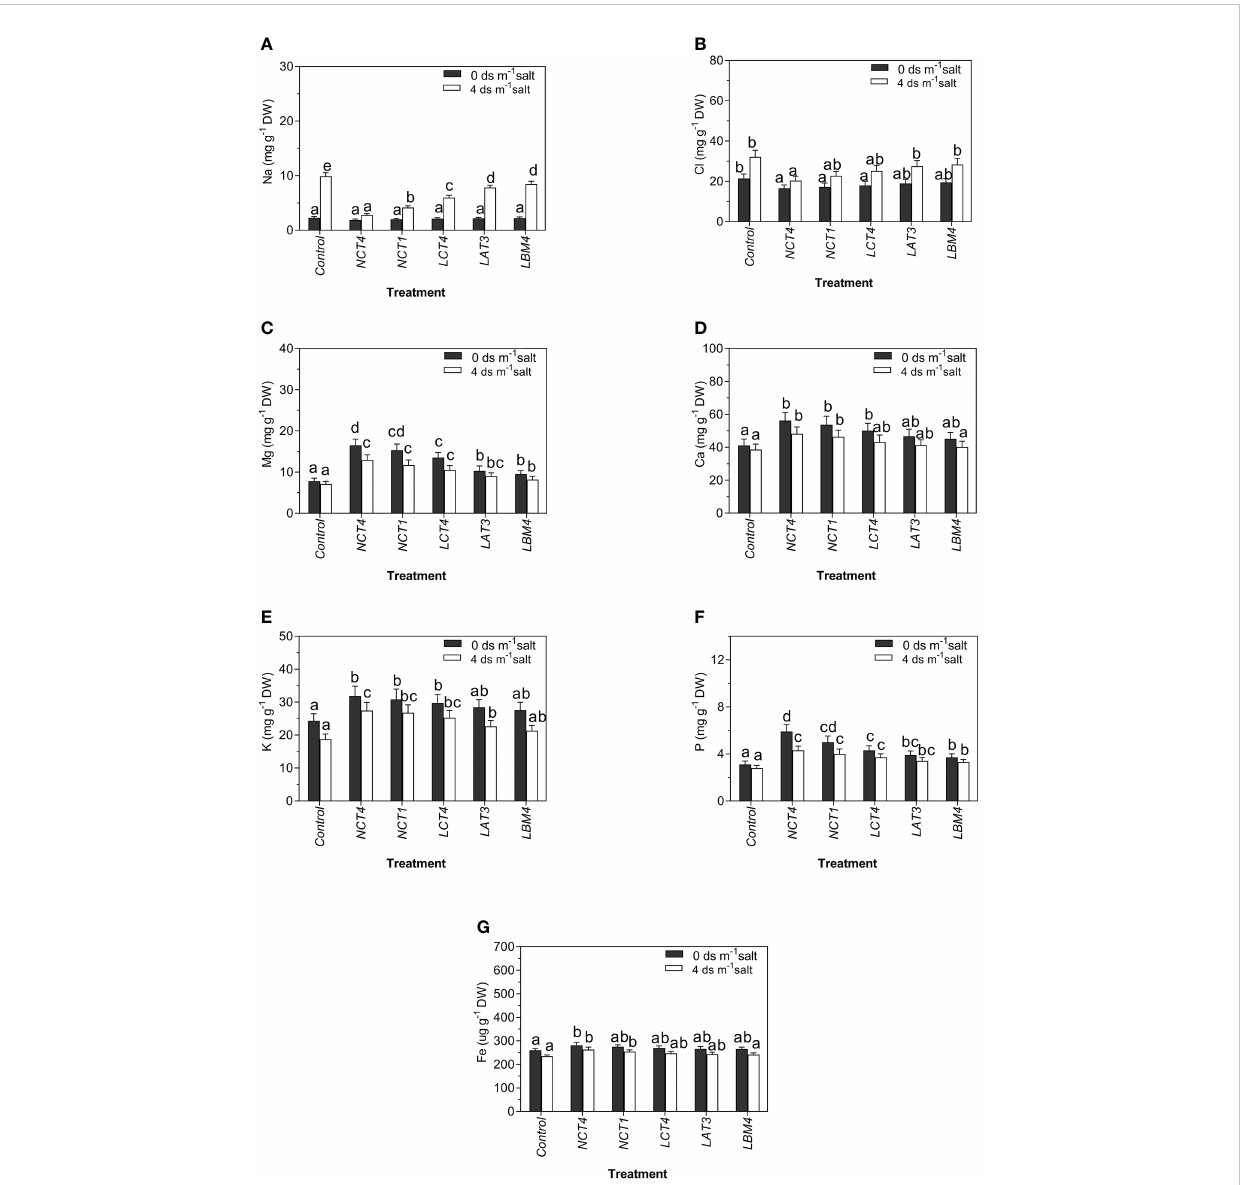
FIGURE 4 Effects of plant growth promoting rhizobacteria (PGPR) on the (A) Na (B) Cl (C) Mg (D) Ca (E) K (F) P (G) Fe of leaf extracts of tomato plant under saline condition. Data were analysed using the One-way ANOVA Tukey ’ s multiple range test (P<0.05). Different small letters have signi fi cant